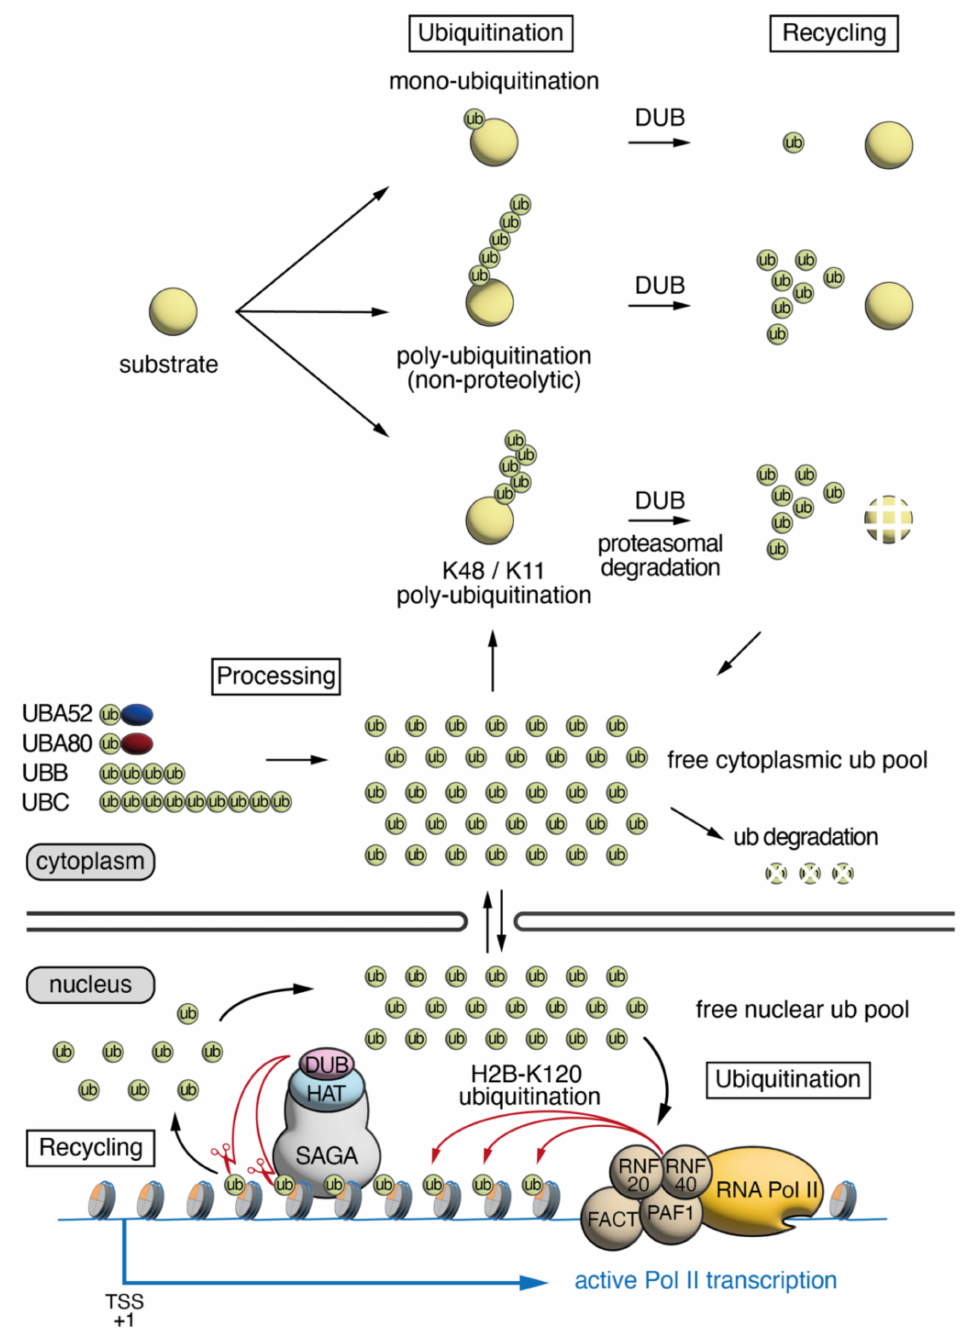
Figure 1. The cellular dynamics of Ubiquitin. Four genes encode ub, Uba52 and Uba80 , which are ub-ribosome subunit fusion genes (ribosome subunits represented by blue and red ovals), as well as Ubb and Ubc , which are polyubiquitin genes encoding for tandem ubs. These ub precursor proteins are processed to generate free ub, which can be ligated to substrates either in a mono- or poly-ubiquitin arrangement. Ub can be liberated from its substrate through the activity of DUB enzymes. The resulting free ub can circulate between the nucleus and the cytoplasm, and be utilized for several processes. In the nucleus ub is ligated to histone H2B via the activity of RNF20/40 in a FACT, PAF1, RNA polymerase II (Pol II) transcription-dependent manner. The DUB module of SAGA removes ub from histone H2Bub1 in a transcription-independent manner, contributing to the cellular pool of free ub. TSS: transcription start